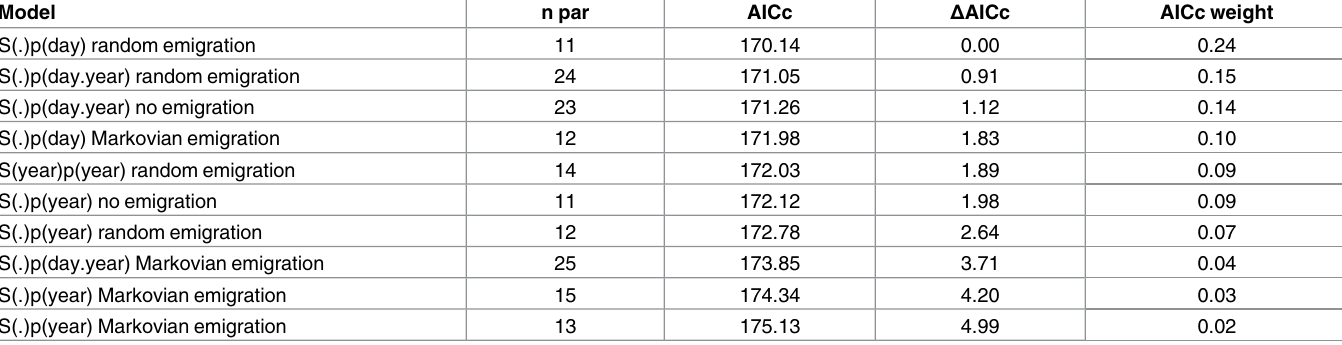
Table 5. First ten models applied to the bottlenose dolphin dataset ranked by lowest AICc, number of parameters (n par) and difference in AICc scores ( Δ AICc). AICc weights indicate strength of evidencefor a given model. S(.) = no variation in apparentsurvival; p(day) = daily variationin capture prob- ability; p(year) = yearly variationin capture probability; p(day.year) = daily and yearly variationin capture probability. Model n par AICc Δ